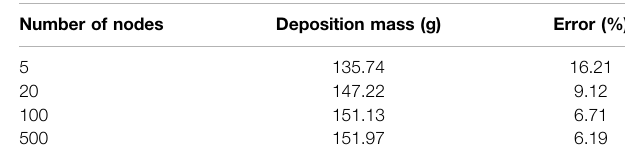
TABLE 2 | The deposited